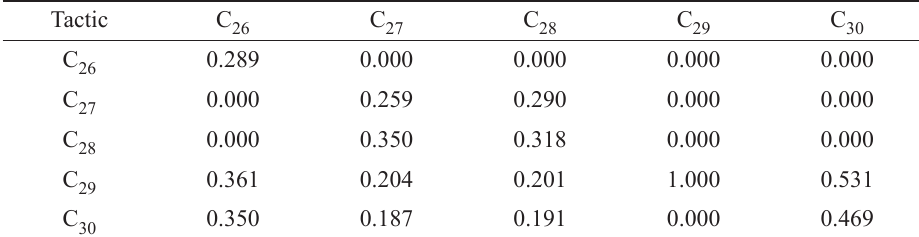
Table 12. The relative importance weights for criteria under the Tactic Group Tactic